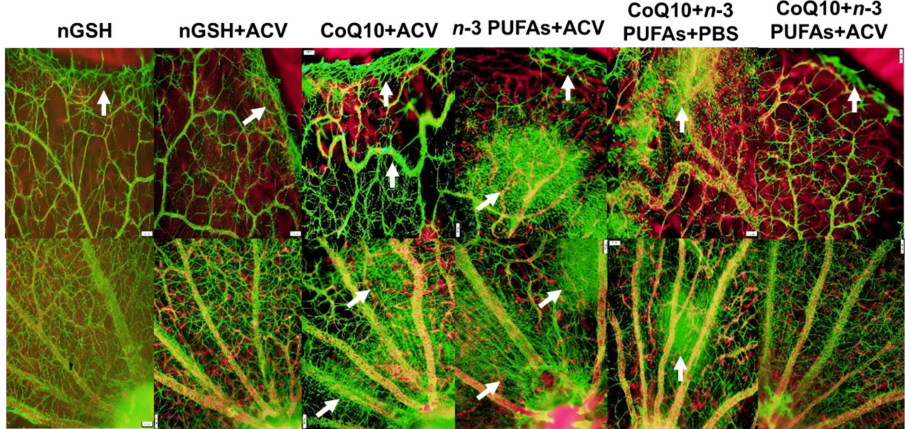
Figure 10. Representative GFAP (green) / isolectin B (red) stained merged images of retinas from rats exposed to neonatal intermittent hypoxia (IH) at postnatal day 21 (P21). The upper panels represent the periphery and the lower panels represent the optic disk. Images are 10 × magnification, scale bar is 100 µ